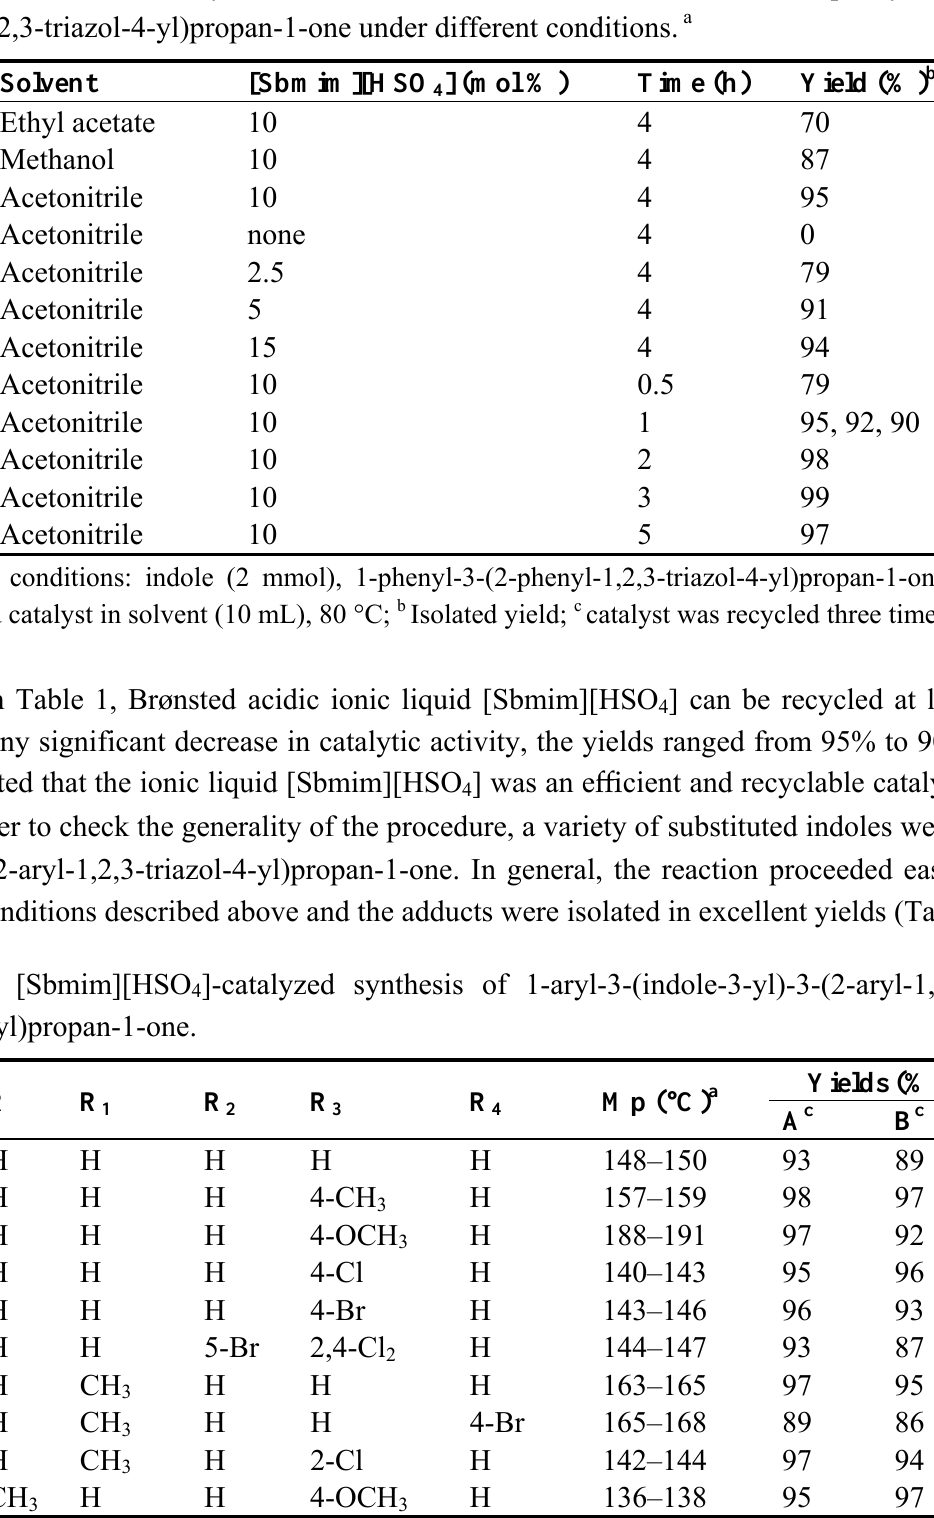
Table 1. Effect of the catalyst [Sbmim][HSO